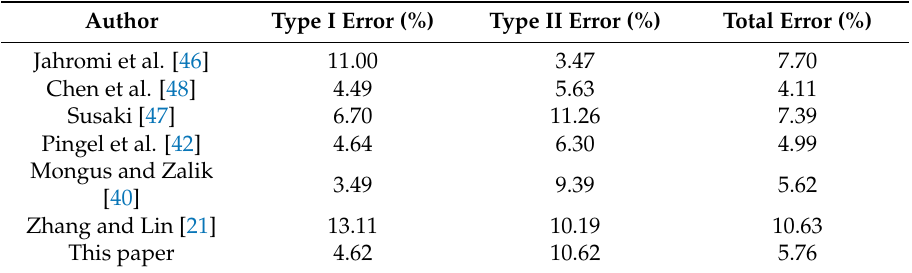
Table 3. Three types of average errors of different filters against ISPRS